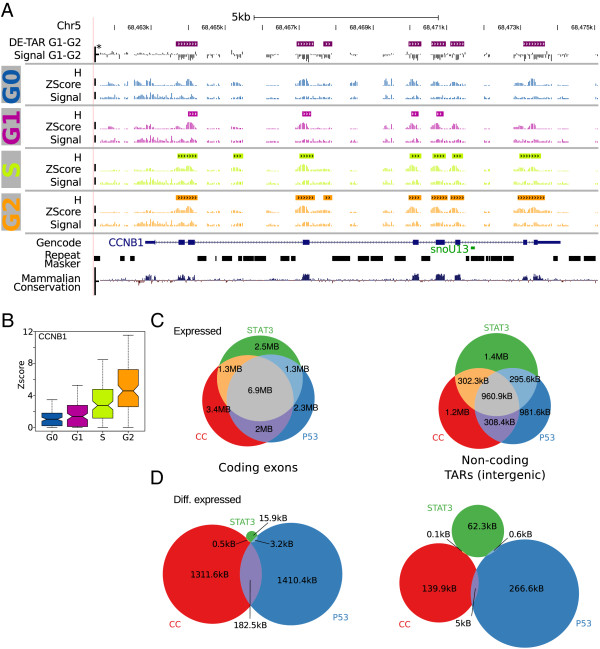
Differentially expressed TARs (DE-TARs).(A) The CCNB1 locus, a positive control for cell-cycle, illustrating the tiling array data analysis workflow employed. For each condition (in this case the cell-cycle phases G0, G1, S and G2), the raw tiling array signal intensities (Signal) in overlapping sliding windows of 200 nt were evaluated to see if the expression was significantly higher than a background distribution, using the TileShuffle algorithm with q<0.05. The background distribution was generated from 10,000 GC controlled permutations of the individual array’s signals. Overlapping windows of significant expression were summarized to intervals labeled H. Analogously, differentially expressed intervals were generated for each pairwise comparison of interest for all intervals designated H in at least one condition of the dataset. Difference signals in windows of the same size were evaluated for a significantly higher differential expression than a background of 100,000 difference shuffles, with q<0.005 and labeled DE-TAR intervals. Repeat masked intervals are missing in the array design due to the ambiguity of probes mapping to these regions. (*) Wiggle track scale bars indicate y-axis scales of (6,16), (0,10), (-3.5,3.5) and (-4,4) for the signal, z-score, differential signal and conservation, respectively. (B) Expression signal from (A) aggregated over all exons of CCNB1. Boxes indicate the median, first and third quantiles. Notches are placed at ±1.58IQR/n and approximate a robust 95% confidence interval. (C) Overlap in expressed nucleotides between STAT3, p53 and cell-cycle (CC) datasets for known coding exons (Gencode v12, UCSC genes, Ensembl and RefSeq) and bona fide non-coding intergenic TARs. (D) Overlap between the three datasets in differentially expressed nucleotides. CC, cell cycle; Chr, chromosome; DE-TAR, significantly differentially expressed TAR; IQR, interquartile range; kb, kilobase; MB, million base pairs; TAR, transcriptionally active region.